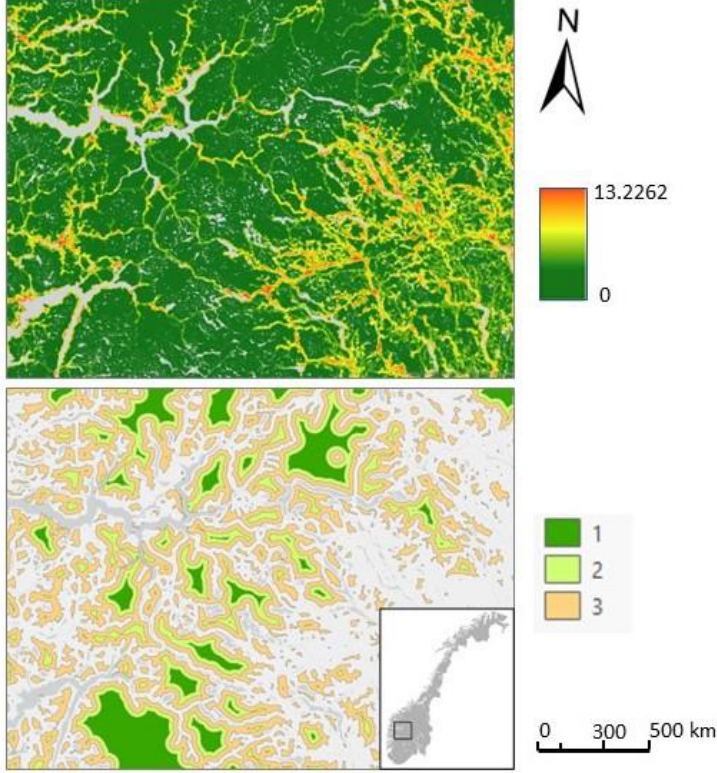
Figure 6. Maps of the western part of central Norway, showing the LUI index value (above) and INON zones 1, 2 and 3. Zone 1 — a more than 5 km distance, zone 2 — a 3 – 5 km distance and zone 3 — a 1 – 3 km distance to the nearest significant infrastructural element (below). White areas are closer than 1 km to infrastructure elements.